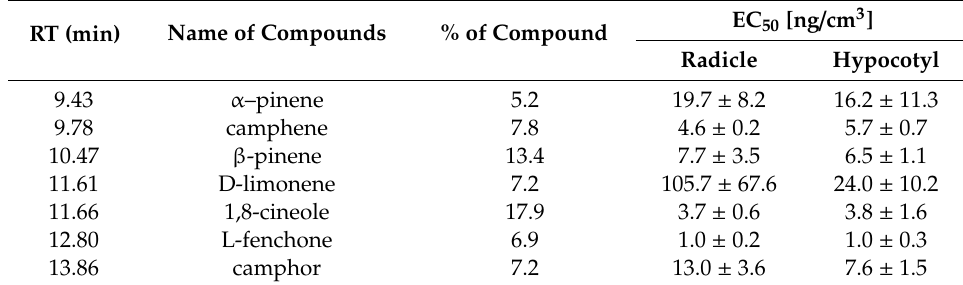
Table 2. Inhibitory activity (EC 50 ) of the seven major compounds detected in the headspace of star anise on radicle and hypocotyl growth of lettuce seedlings.